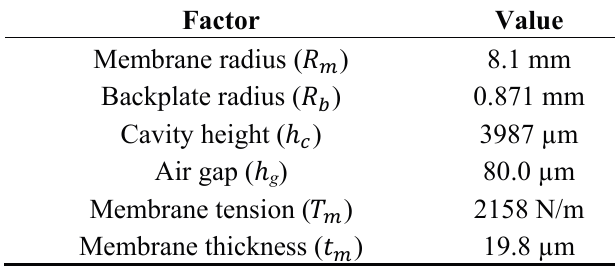
Figure 11. Optimum zone for acoustic resonant sensor with desired responses. Table 7. Set of optimized parameters based on multi-criteria desirability functions